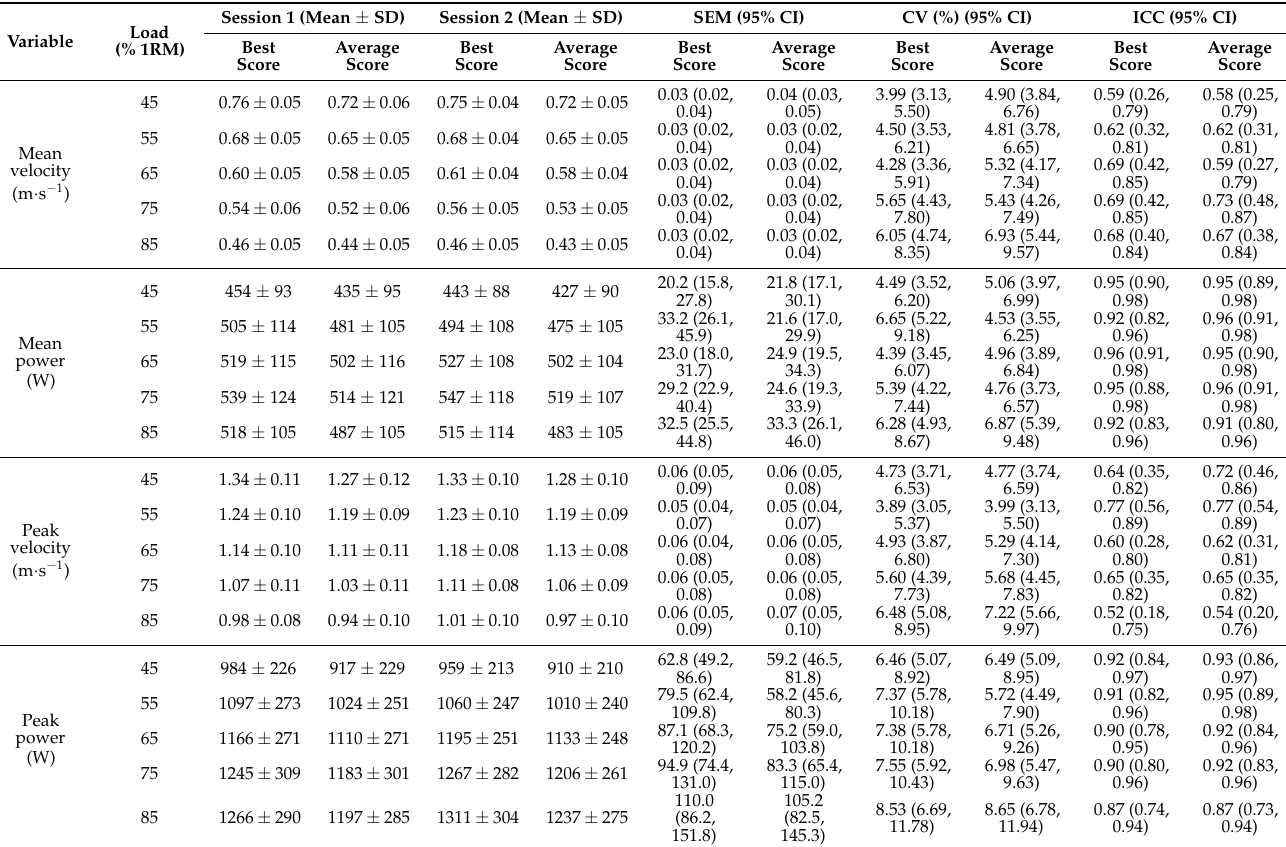
Table 1. Between-session reliability of mean velocity, mean power, peak velocity, and peak power variables obtained from the best and average scores of 3 repetitions during the back-squat exercise performed with the pause technique at different